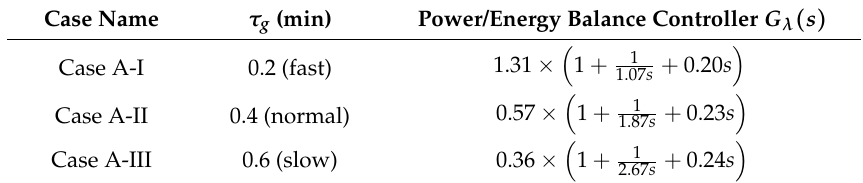
Table 3. Three designs of the power/energy balance controller in the simulation of a generation failure scenario.